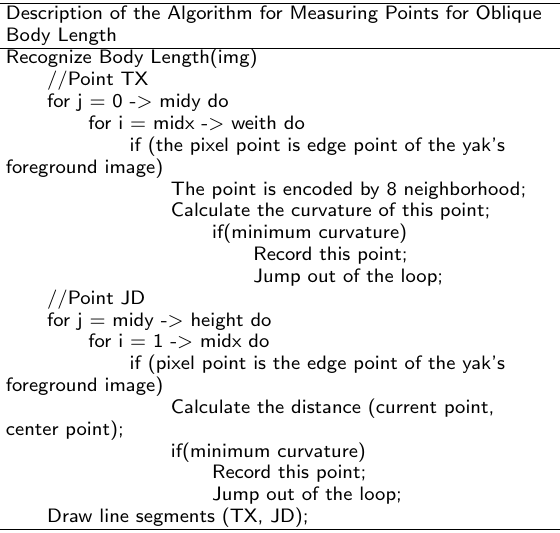
Algorithm 3 Recognition Algorithm of Measuring Points for Oblique Body